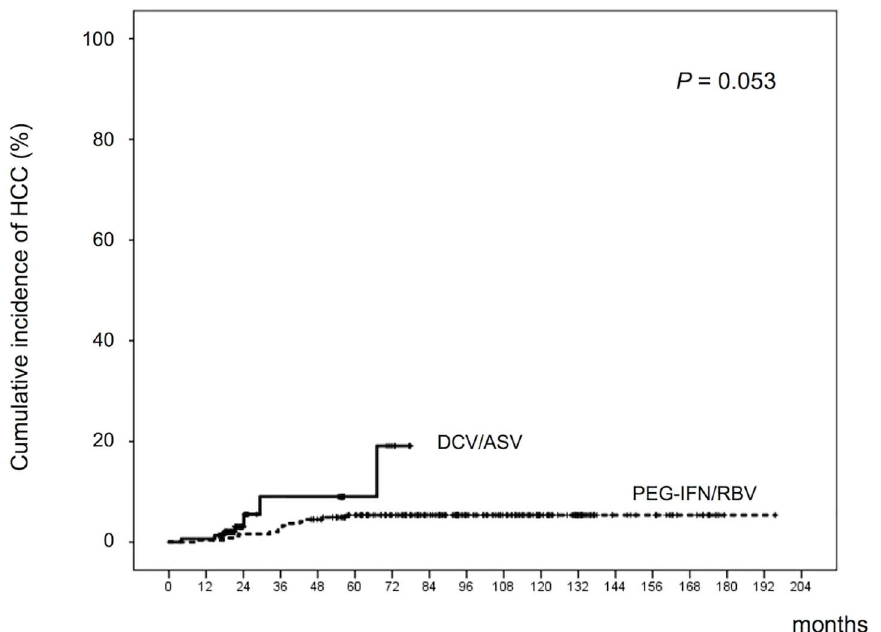
Fig 1. Cumulative hepatocellular carcinoma (HCC) development. Patients who achievedviral eradication by peg-interferon and ribavirin(PEG-IFN/RBV) or daclatasvirplus asunaprevir(DCV/ASV) therapieswere